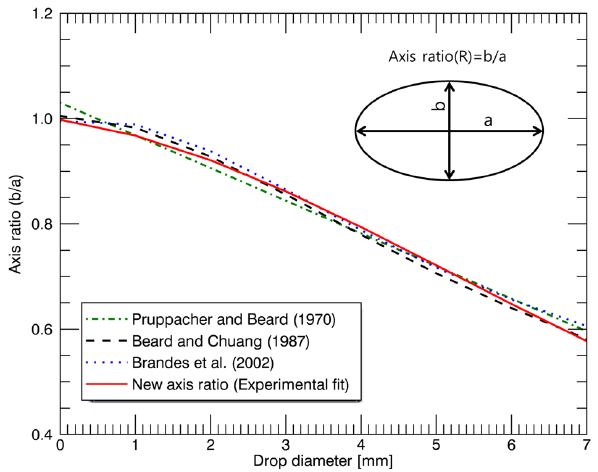
Figure 5. Different raindrop axis-ratio relations for the oblate rain- drop model. The upper right subfigure illustrates the axis ratio of an oblate